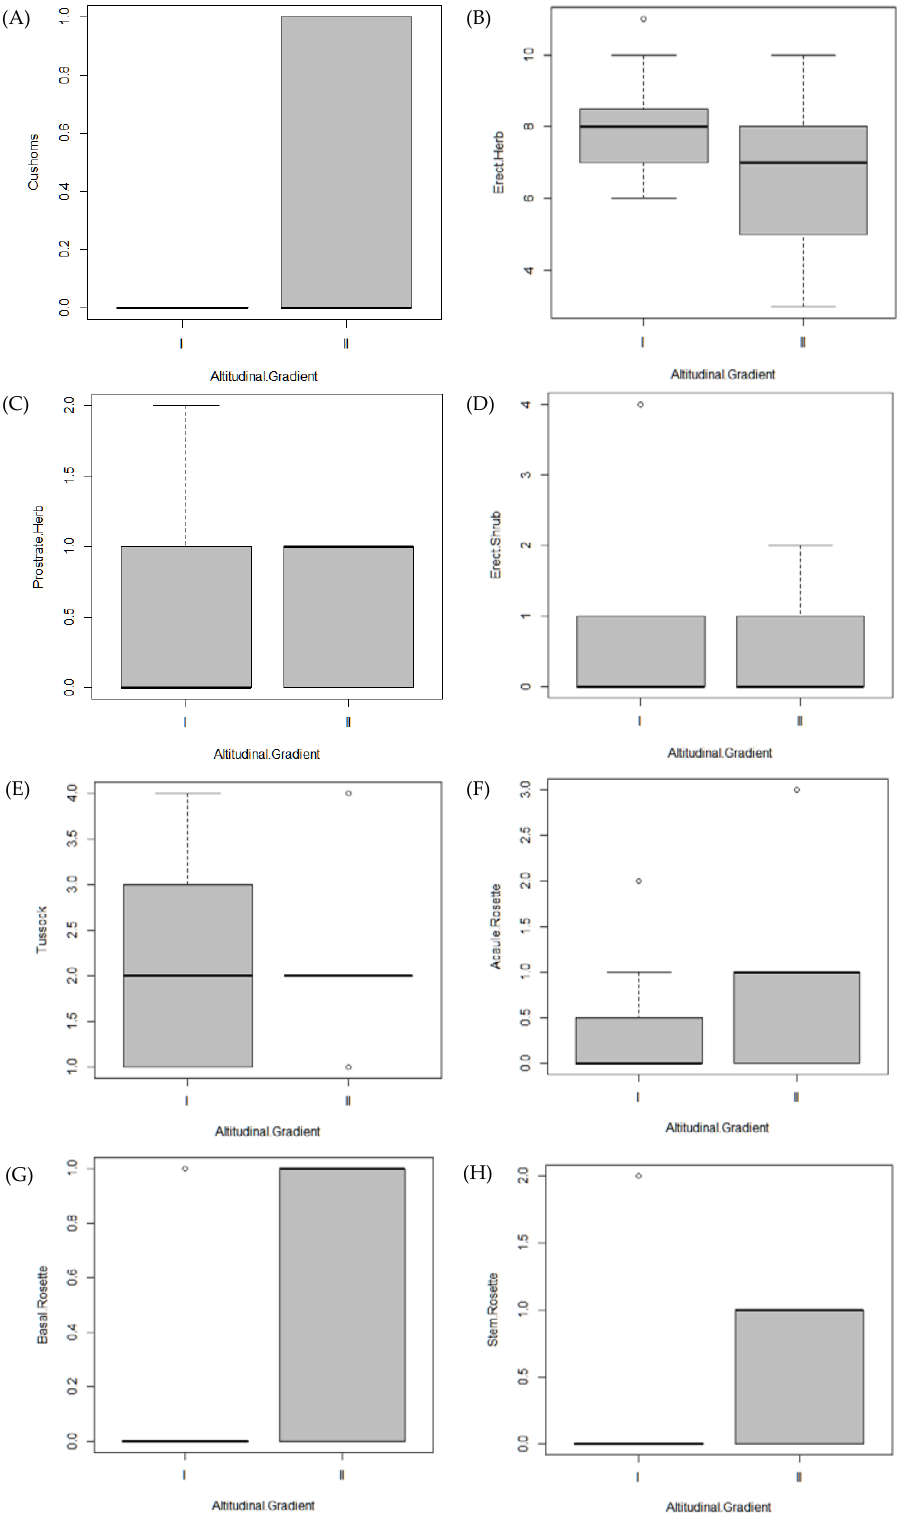
Figure 5. All Lifeforms’ plant boxplot by altitudinal gradients. The altitudinal gradients are plotted versus ( A ) Cushion; ( B ) Erect Herb; ( C ) Prostrate Herb; ( D ) Erect. Shrub; ( E ) Tussock; ( F ) Acaulescent Rosette; ( G ) Basal Rosette; ( H ) Stem Rosette.